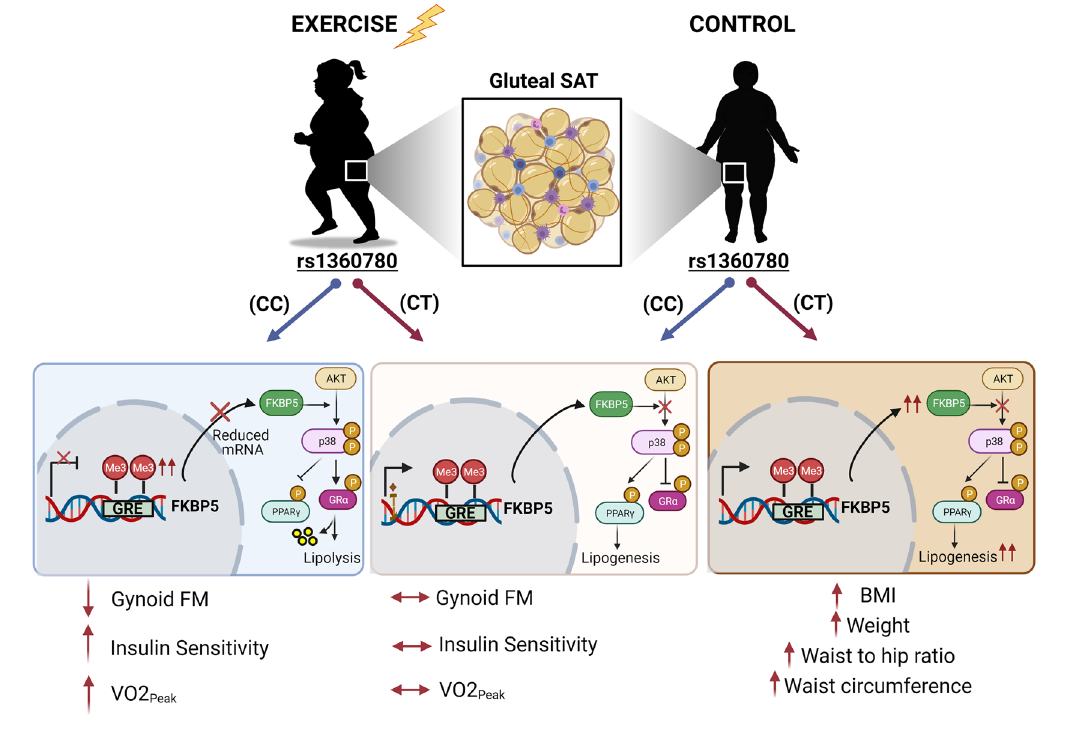
Figure 6. Schematic proposed model of study findings showing how exercise intervention can lead to intronic hypermethylation and downregulation of FKBP5 expression in individuals harbouring “protective” rs1360780 CC genotype. Reduced FKBP5 in turn may lead to re-activation of the Akt-p38 MAPK pathway, favouring GRα- induced lipolysis of gynoid fat mass (FM) and consequently improving insulin sensitivity and